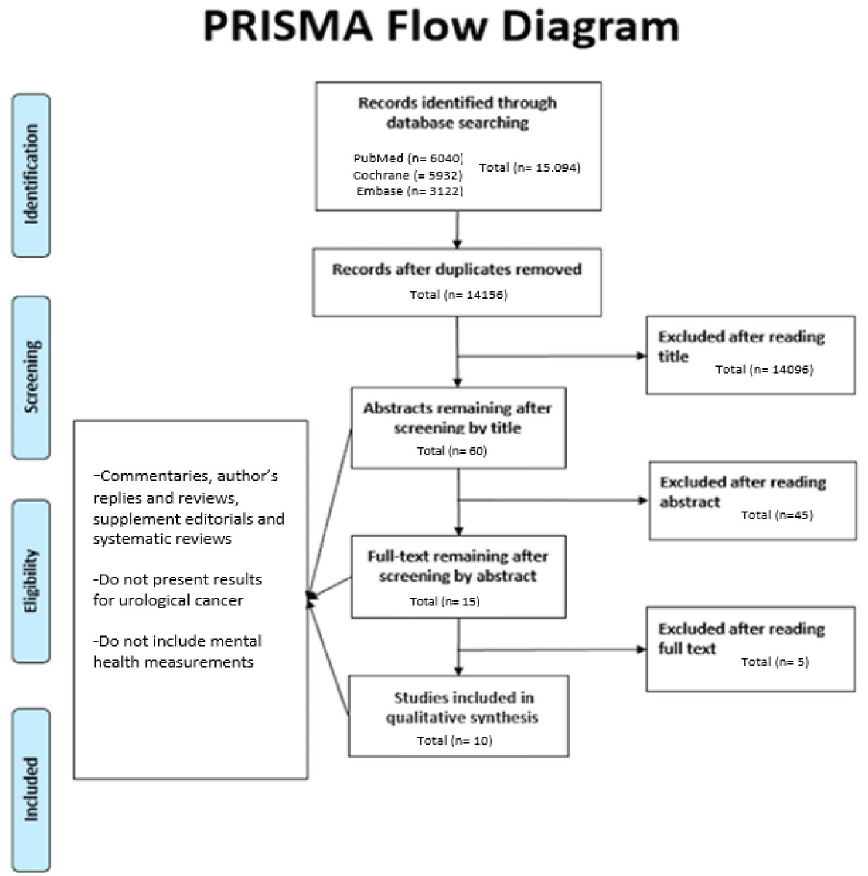
Fig 1. PRISMA Flow diagram for selection of studies in systematic